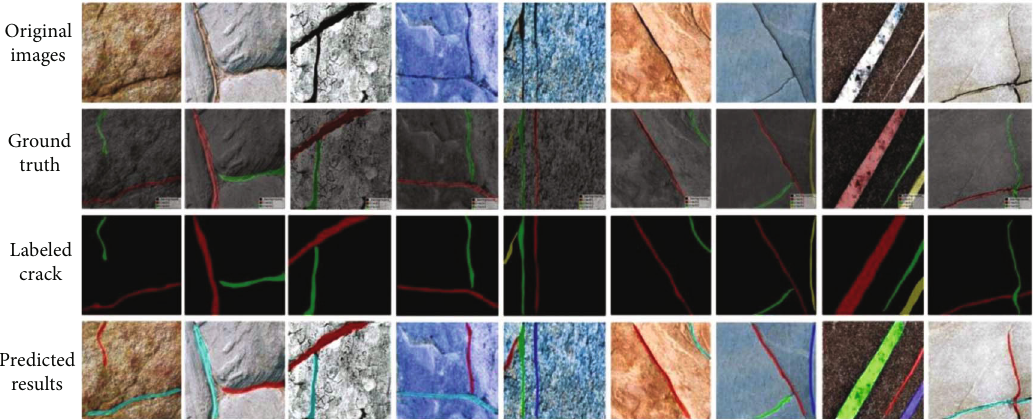
Figure 15: Examples of predicted results of the multi-CrackNet on 2-3 sets of crack